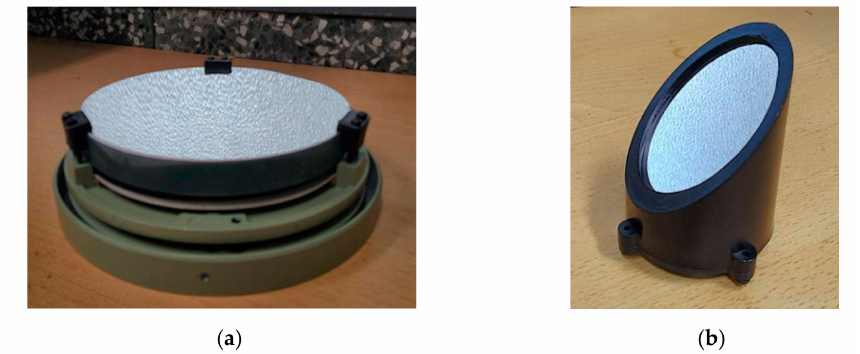
Figure 8. ( a ) Ag-enhanced primary mirror of the telescope, approximately 15 cm in diameter; ( b ) Ag- enhanced secondary mirror of the telescope, with a diameter of 5 cm.